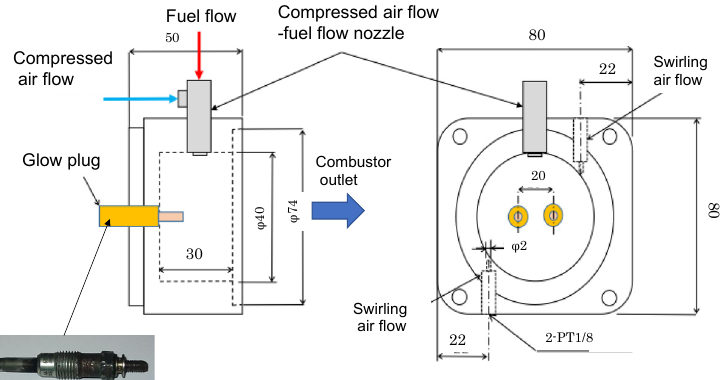
Figure 2. Upstream of the combustor.